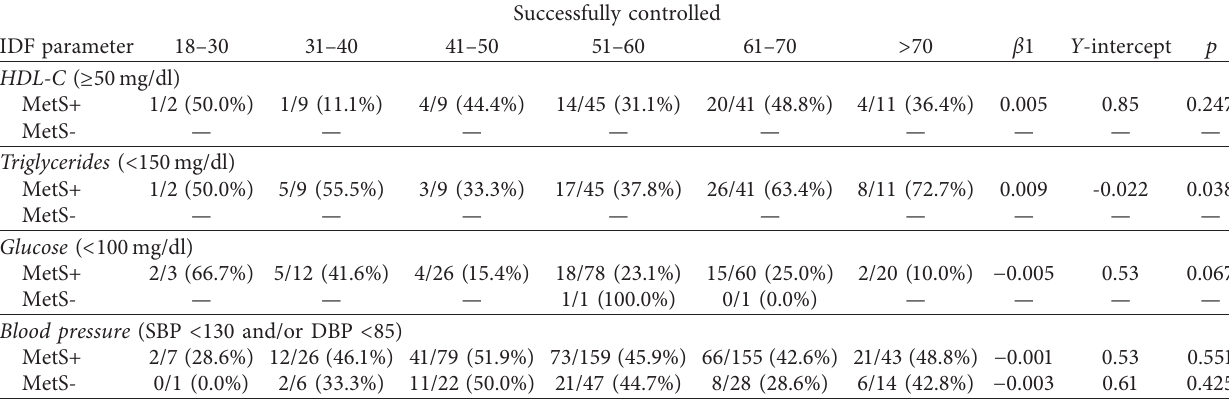
Table 5: Obese patients with or without metabolic syndrome, subdivided among age ranges, treated with hypolipidaemic drugs, hypoglycaemics, and/or antihypertensives and successfully controlled in accordance with the cut-offs of the IDF diagnostic criteria for HDL-C, triglycerides, glucose, and blood